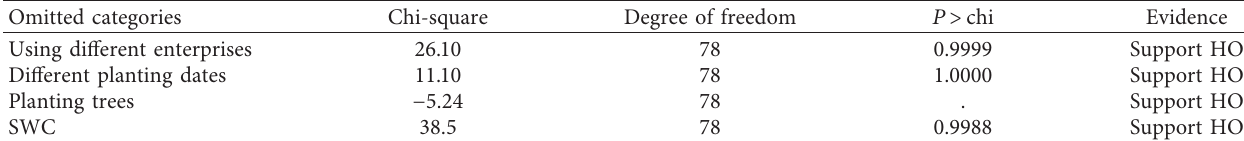
Table 2: Hausman-McFadden test of IIA